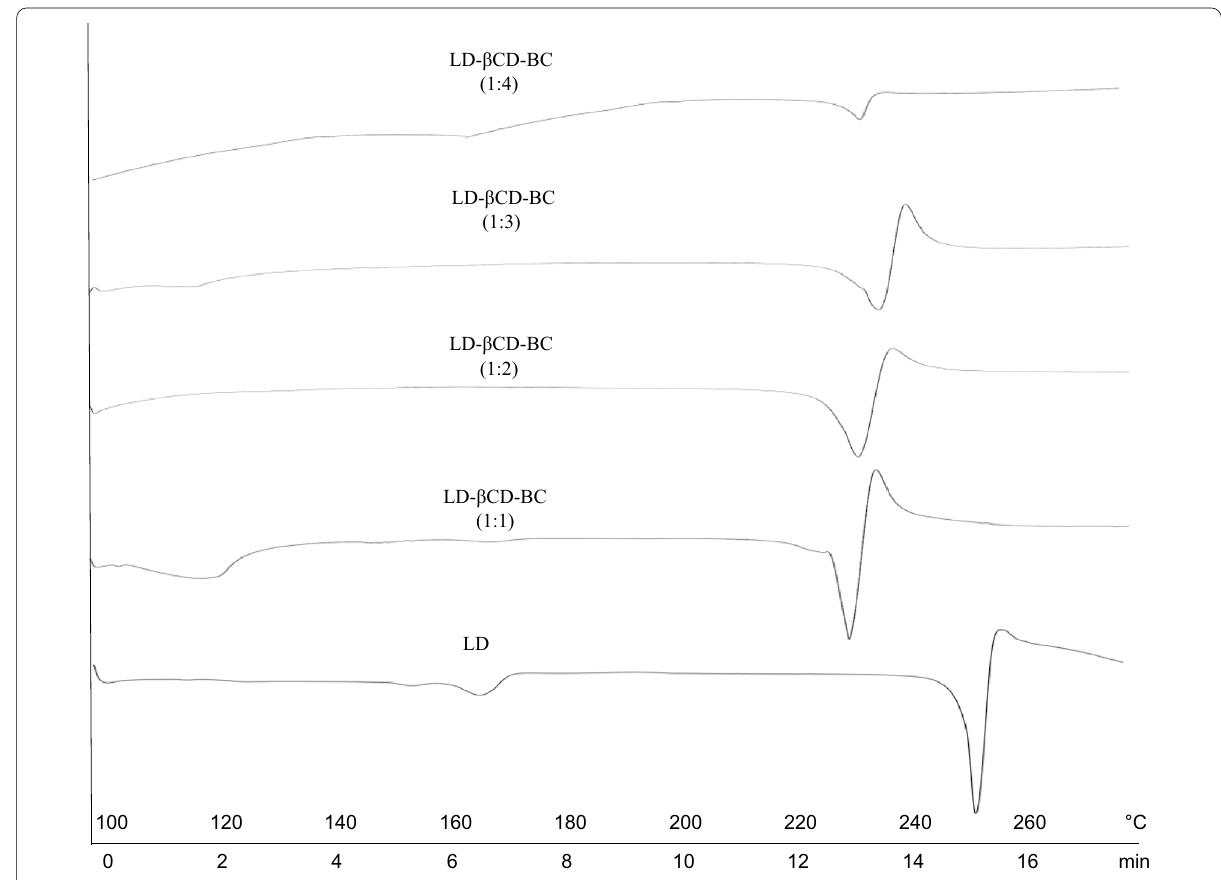
Fig. 8 DSC thermograms of LD, and its prepared freeze-dried, binary complexes of different ratios, LD-βCD-BC (1:1), LD-βCD-BC (1:2), LD-βCD-BC (1:3), and LD-βCD-BC